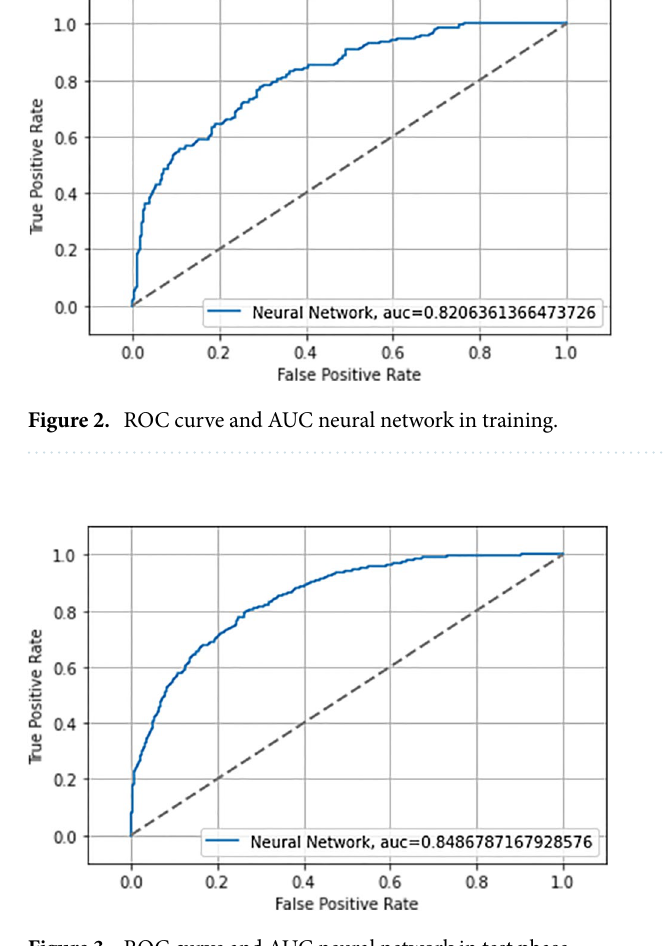
Figure 3. ROC curve and AUC neural network in test